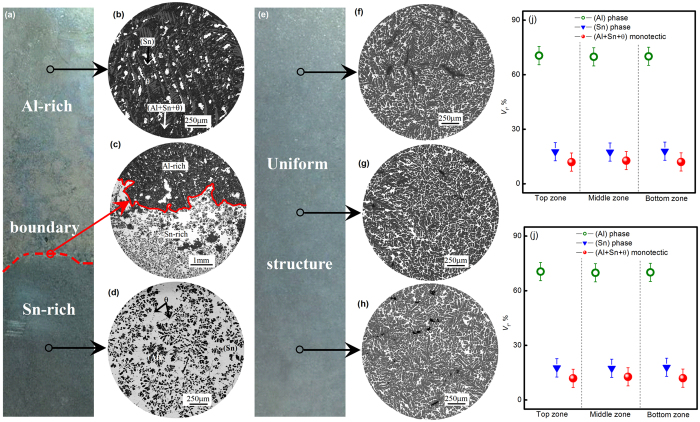
Solidification microstructure of ternary Al71.9Sn20.4Cu7.7 alloy: (a) layered-structure after static solidification; (b)~(d) structural morphologies in different locations during static solidification; (e) uniform structure under 3D ultrasounds; (f~h) microstructures of the top, middle and bottom parts of the alloy sample solidified under 3D ultrasounds. (i) volume fraction of different microstructures in Al-rich and Sn-rich zones in the static sample; (j) volume fraction of different microstructures in top, middle and bottom parts of the sample solidified under 3D ultrasounds.